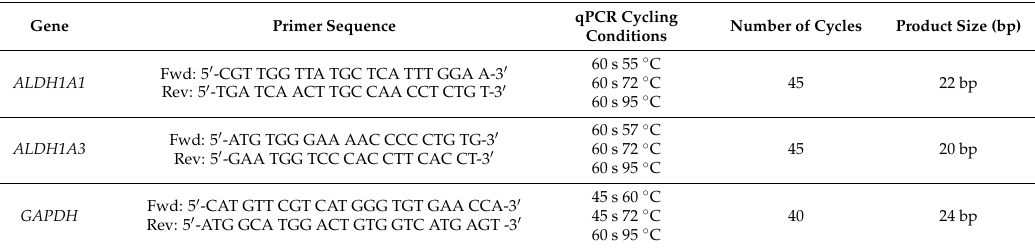
Table 2. Primers and qPCR